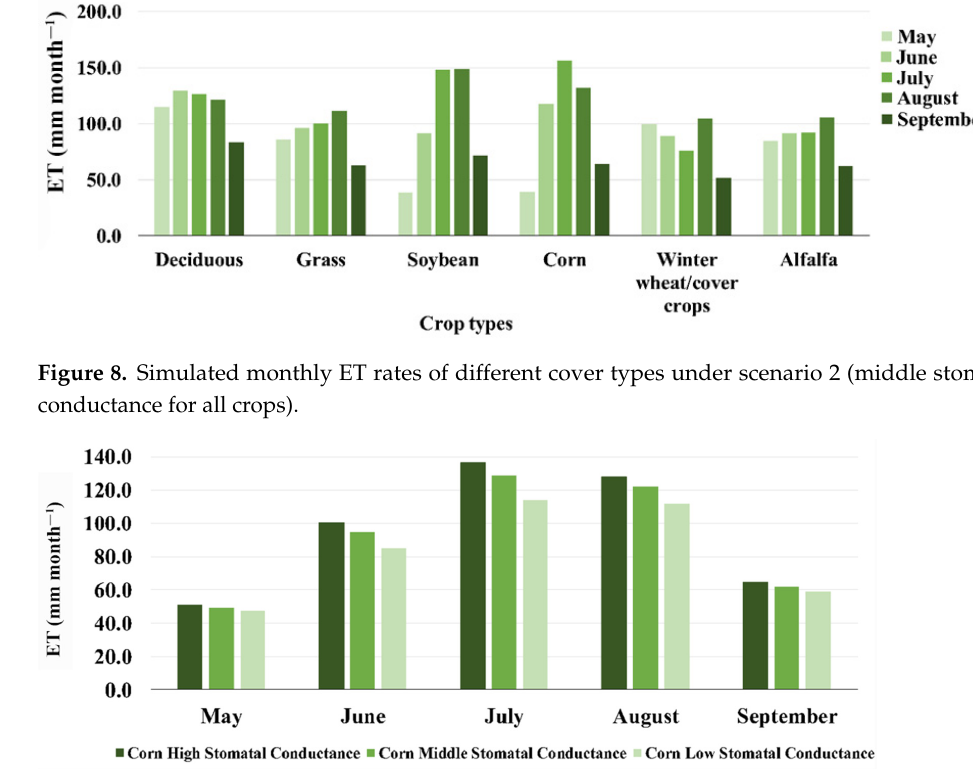
Figure 9. Simulated monthly mean watershed ET rates under high, middle, and low stomatal conductance for corn and middle stomatal conductance for all other crops. 3.3. Estimated ET Rates under Different Percentages of Corn Cover Other vegetation was replaced with corn in the simulation to explore the potential effect of a shift to C4 monocrop cultivation on the ET rate of the watershed. When the corn cover increased from the existing state in 2018 to 100% of vegetated cover (Figure 10), there was a gradual increase in the ET rate for both July and August, but no significant difference in the ET rate was observed (Figures 11 and 12). The change in ET showed an increase of 5.05% in July and 3.96% in August. Note, however, that the ET rate was less variable with increased corn cover.